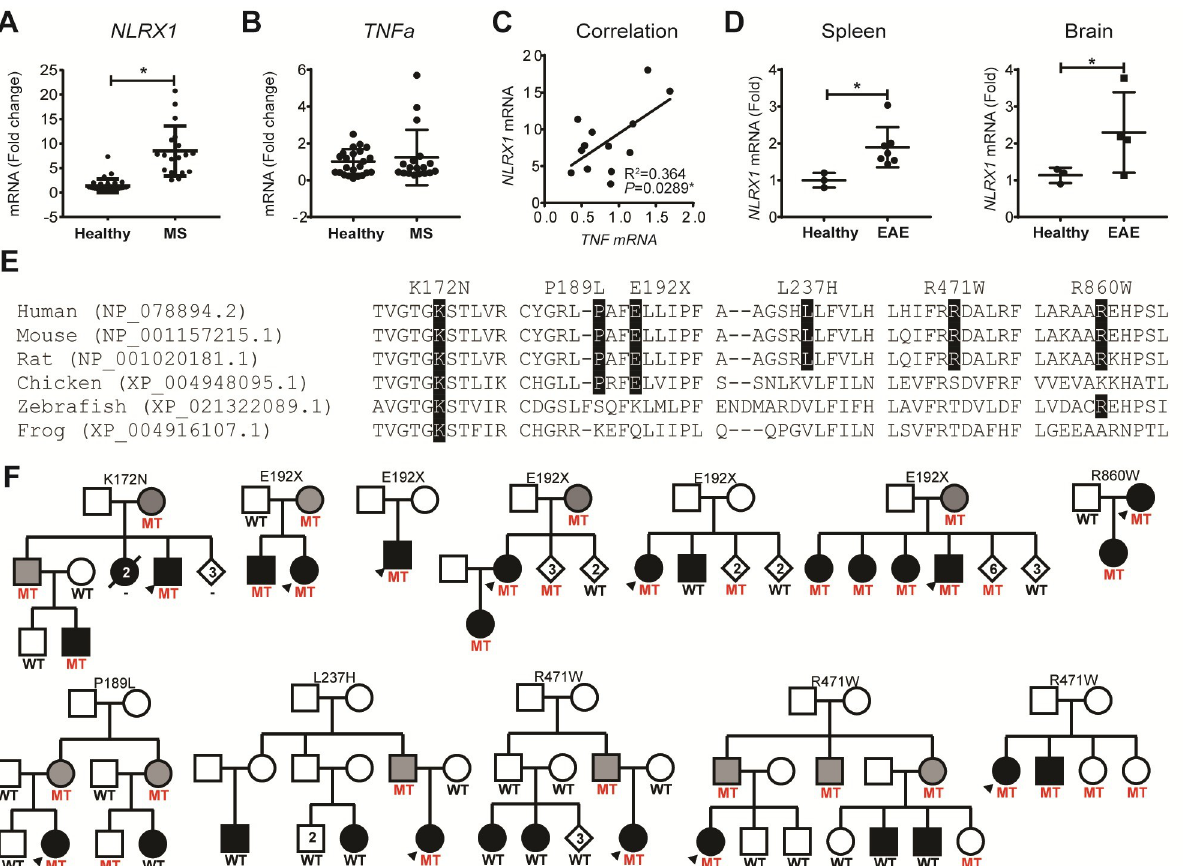
Fig 6. NLRX1: Implications for human MS. (A) Expression of NLRX1 in PBMC from MS patients ( n = 18) compared with healthy donors ( n = 31), quantified using qPCR. The data are presented as mean ± SD; � P � 0.05, determined by two-tailed Student t test. (B) The mRNA levels of TNF α expression in PBMC from MS patients ( n = 18) and healthy individuals ( n = 28), measured by qPCR. (C) Correlation between mRNA levels of NLRX1 and TNF α in the PBMC from MS samples ( n = 13), statistically determined using Pearson correlation coefficient, r = 0.604, � P = 0.029. (D) Expression of Nlrx1 in the spleen and brain of C57BL/6J mice with classical EAE compared with healthy mice. The WT mice were immunized with MOG/CFA and pertussis. The brain and spleen were collected 3 weeks after immunization; � P � 0.05, determined by two-tailed Student t test. Underlying data can be found in S1 Data. (E) NLRX1 conservation in orthologs. Evolutionarily conserved positions for the identified mutations are highlighted in black. Organism and RefSeq accession numbers are provided. (F) Pedigrees for families identified with NLRX1 mutations. Black filled symbol, MS; gray filled, unaffected obligate carrier. Heterozygote mutation carriers (MT) and WT genotypes are indicated. CFA, Complete Freund’s Adjuvant; EAE, experimental autoimmune encephalomyelitis; MOG, myelin oligodendrocyte glycoprotein; MS, multiple sclerosis; MT, mutation carrier; NLRX1, nucleotide-binding, leucine-rich repeat containing X1; PBMC, peripheral blood mononuclear cell; qPCR, quantitative polymerase chain reaction; TNF α , tumor necrosis factor alpha; WT,